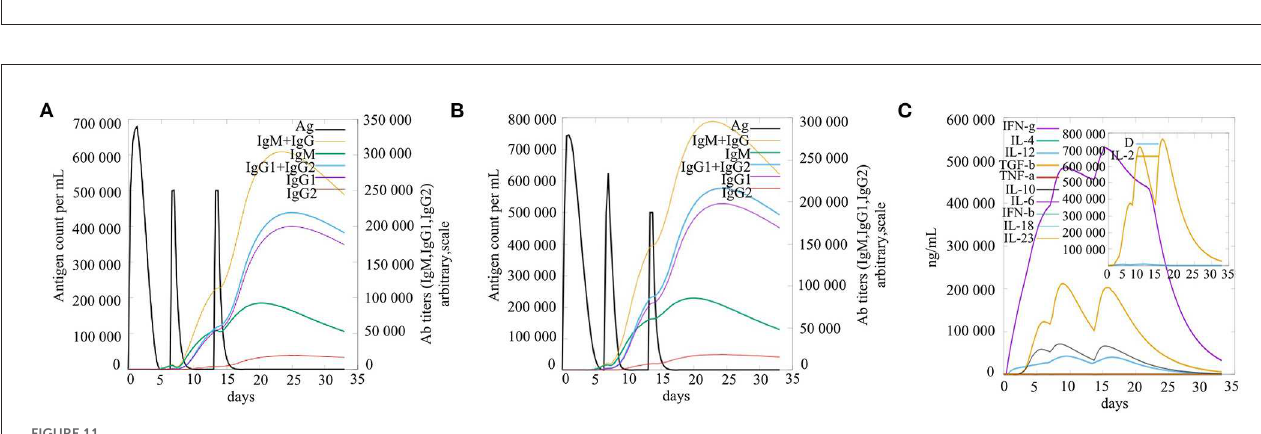
FIGURE10 CTL, NK, MA, DC, EP cell counts shown in silico immune simulation. (A) CD8 T-cytotoxic lymphocytes count, Total and memory shown; (B) CD8 T-cytotoxic lymphocytes count per entity-state; (C) Natural Killer cells (total count); (D) Epithelial cells, Total count broken down to acgive, virus-infected and presenting on class-I MHC molecule; (E) Macrophages. Total count, internalized, presenting on MHC class-II, active and resting macrophages; (F) Dendritic cells, DC can present antigenic peptides on both MHC class-I and class-II molecules, The curves show the total number broken down to active, resting, internalized and presenting the ag; Act, active; Intern, internalized the Ag; Pres II, presenting on MHC II; Dup, in the mitotic cycle; Anergic, anergic; Resting, not active.